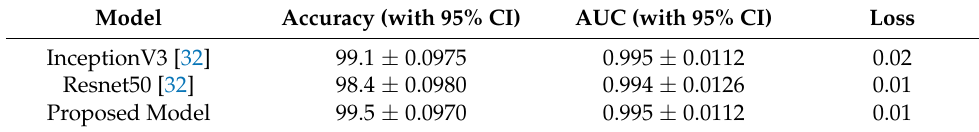
Table 2. Performance of various models for forecasting COVID-19/pneumothorax.